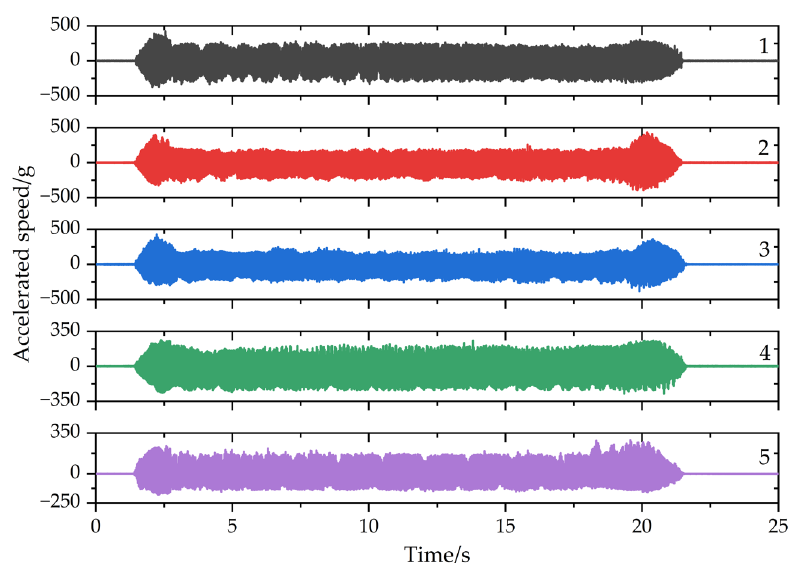
Figure 11. Acceleration responses in different milling stages.